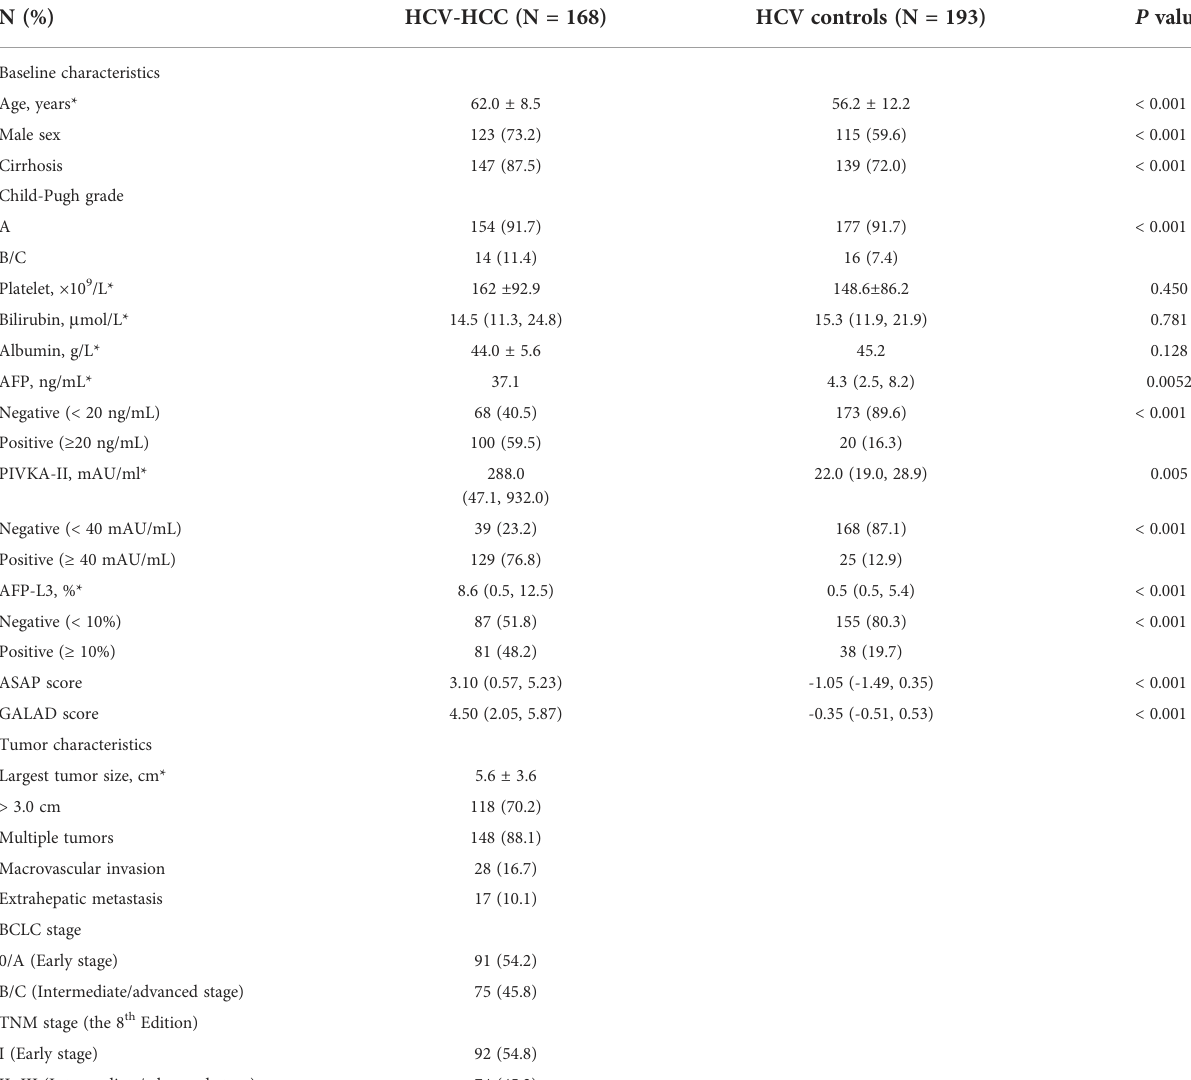
TABLE 1 Clinical characteristics of the overall